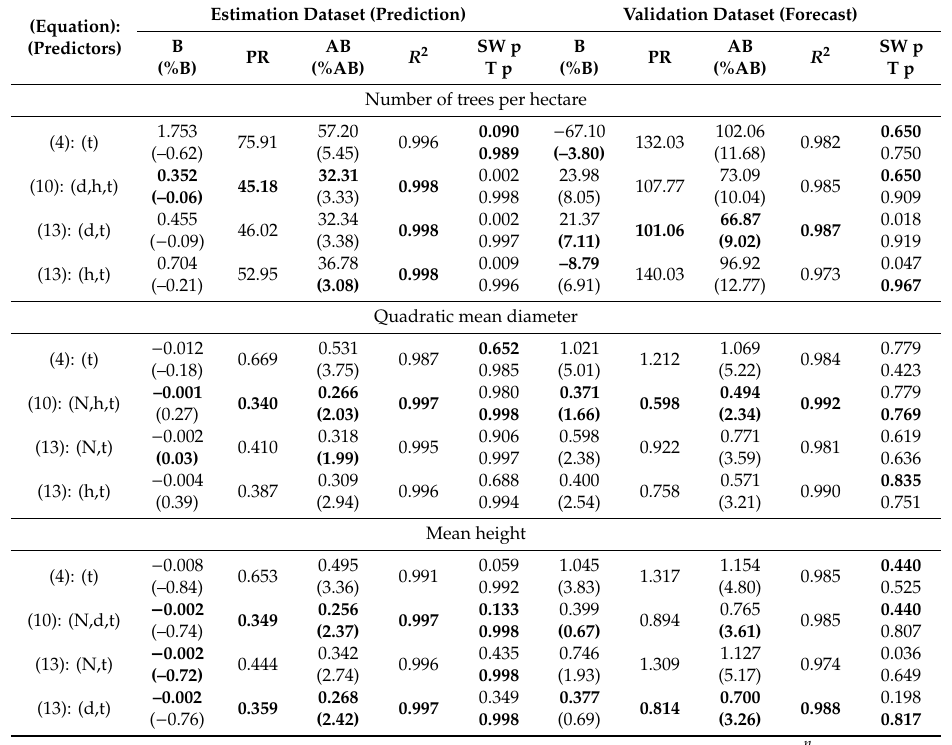
n (cid:80) ( y i − ˆ y i ) ) and n i = 1